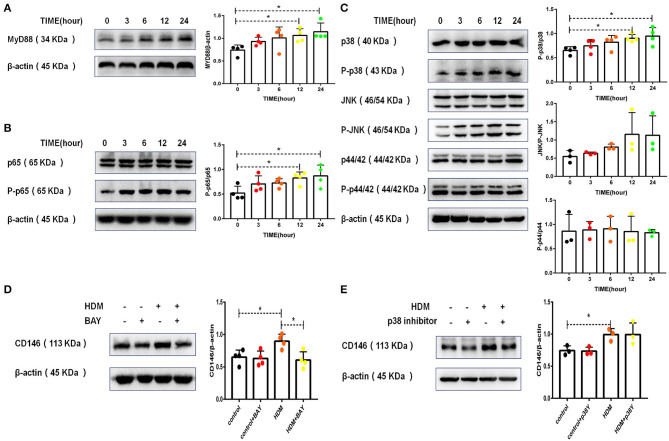
CD146 expression in alveolar epithelial cells was dependent on p65. (A) Western blot analysis of MyD88 expression in MLE-12 cells treated with HDM extract (100 μg/ml). (B) Western blot analysis of NF-κB p65 expression in MLE-12 cells treated with HDM extract (100 μg/ml). (C) Western blot analysis of MAPK expression in MLE-12 cells treated with HDM extract (100 μg/ml). (D) Western blot analysis of CD146 expression in MLE-12 cells treated with HDM extract (100 μg/ml) and a p65 inhibitor (BAY, 10 μm) for 24 h. (E) Western blot analysis of CD146 expression in MLE-12 cells treated with HDM extract and a p38 inhibitor (SB203580, 10 μm) for 24 h. *P < 0.05.